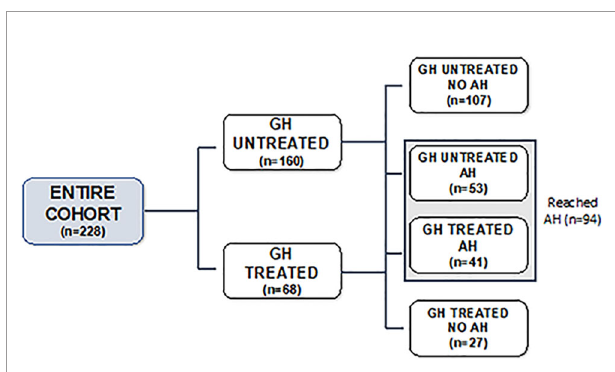
FIGURE 1 | Flow chart of the study